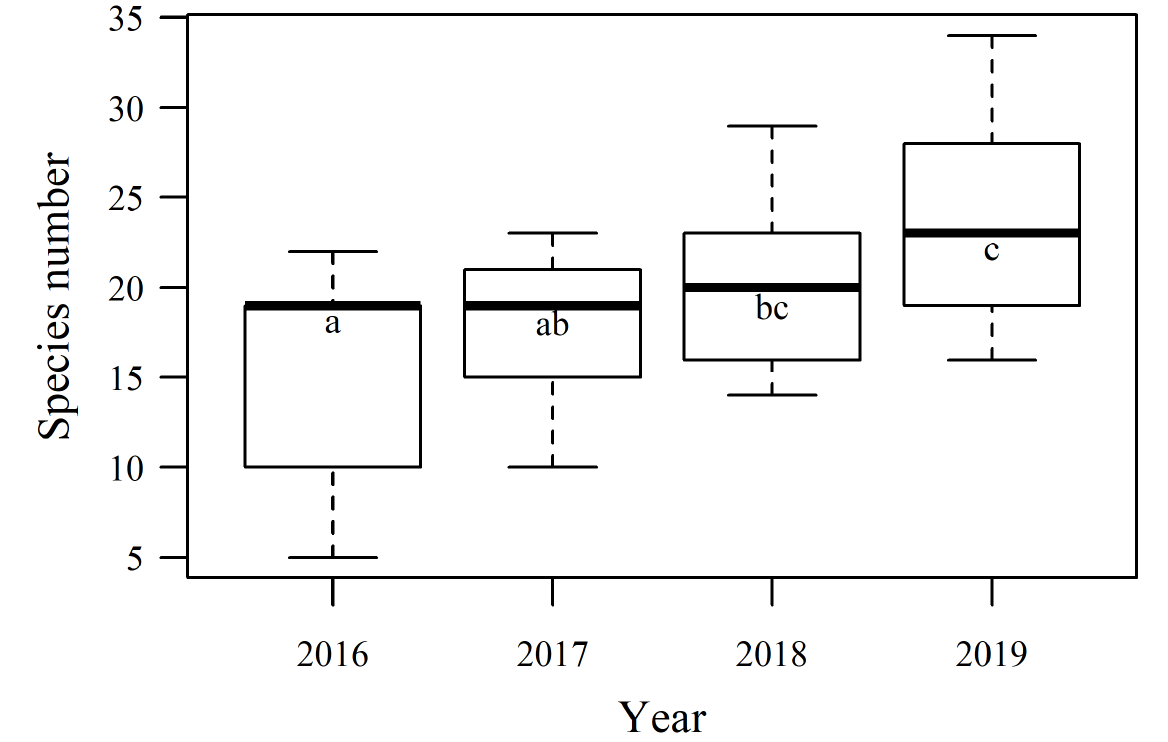
Figure 1. The results of a one-way analysis of variance (ANOVA) for the total number of species. Different letters indicate significant differences (p = 0.05) .